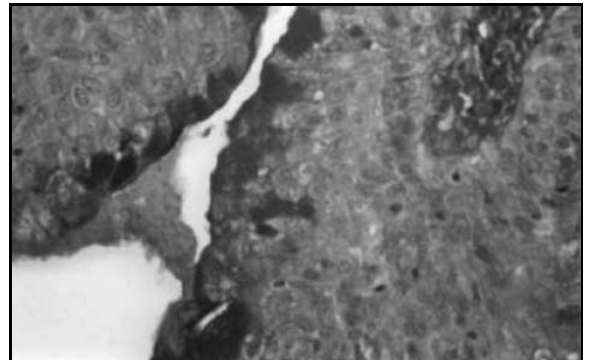
Figura 2 – Histopatologia do condiloma imaturo (caso 1): lesão papilar composta de epitélio metaplásico imaturo com atipias discretas, ausência de coilocitose e presença de células endocervicais na superfície. Em destaque (setas), áreas citoplasmáticas mais escuras nas células superficiais revelam a presença de muco intracitoplasmático (coloração de PAS, aumento de